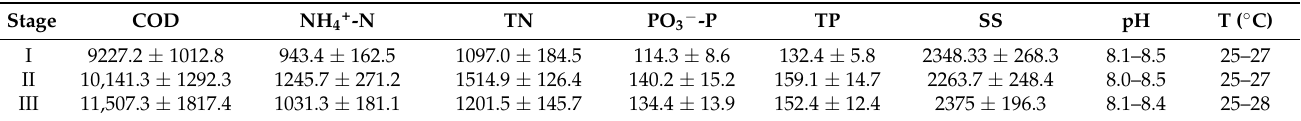
Table 1. Characteristics of influent swine wastewater at different stages